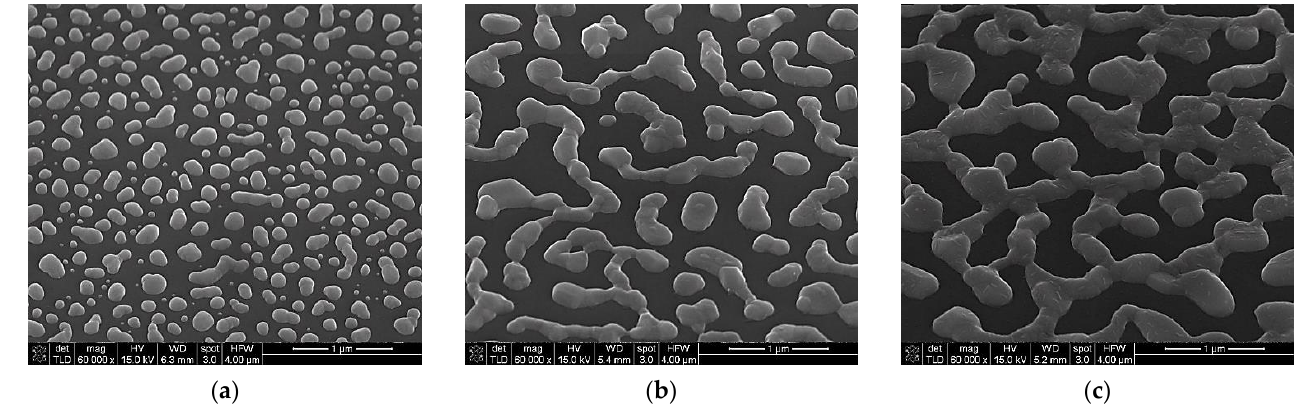
Figure 11. SEM micrographs of thick Ag layers after the specific thermal annealing performed to obtain the metallic meta-atoms: ( a ) — 15 nm, ( b ) — 20 nm, ( c ) — 30 nm. obtain the metallic meta-atoms: ( a )—15 nm, ( b )—20 nm, ( c )—30 nm.